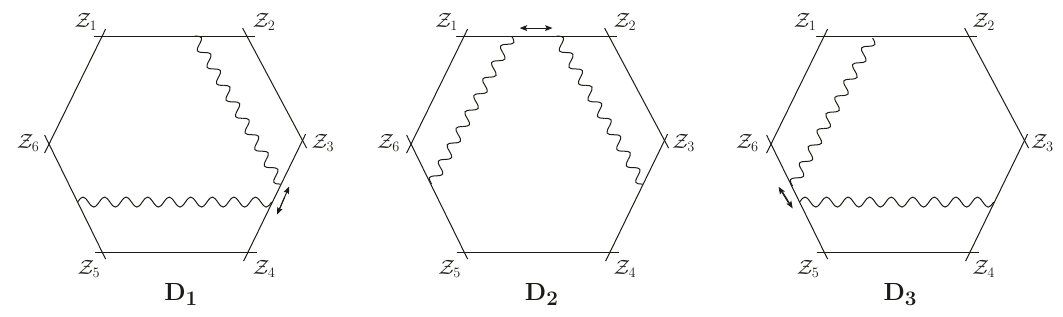
Figure 6 . Three diagrams each having a new type of spurious pole occurring when the propagator ends touch. In the sum of the three diagrams however this pole cancels. Note that although this is drawn at six points for de(cid:12)niteness the cancellation only depends on the three sides taking part and can be directly repeated at n